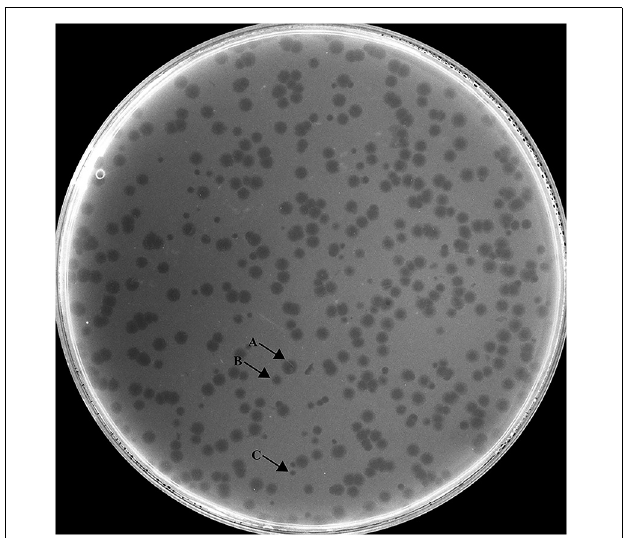
FIGURE 1 | Morphology of Hafnia phage Ca plaques. Hafnia phage Ca always developed variable sizes of plaques (at least three obviously different sizes) when a single plaque was picked out and inoculated on a double-layer Luria broth agar plate with H. paralvei LY-23. Arrow A indicates large plaque, Arrow B indicates medium-sized plaque, and Arrow C indicates small